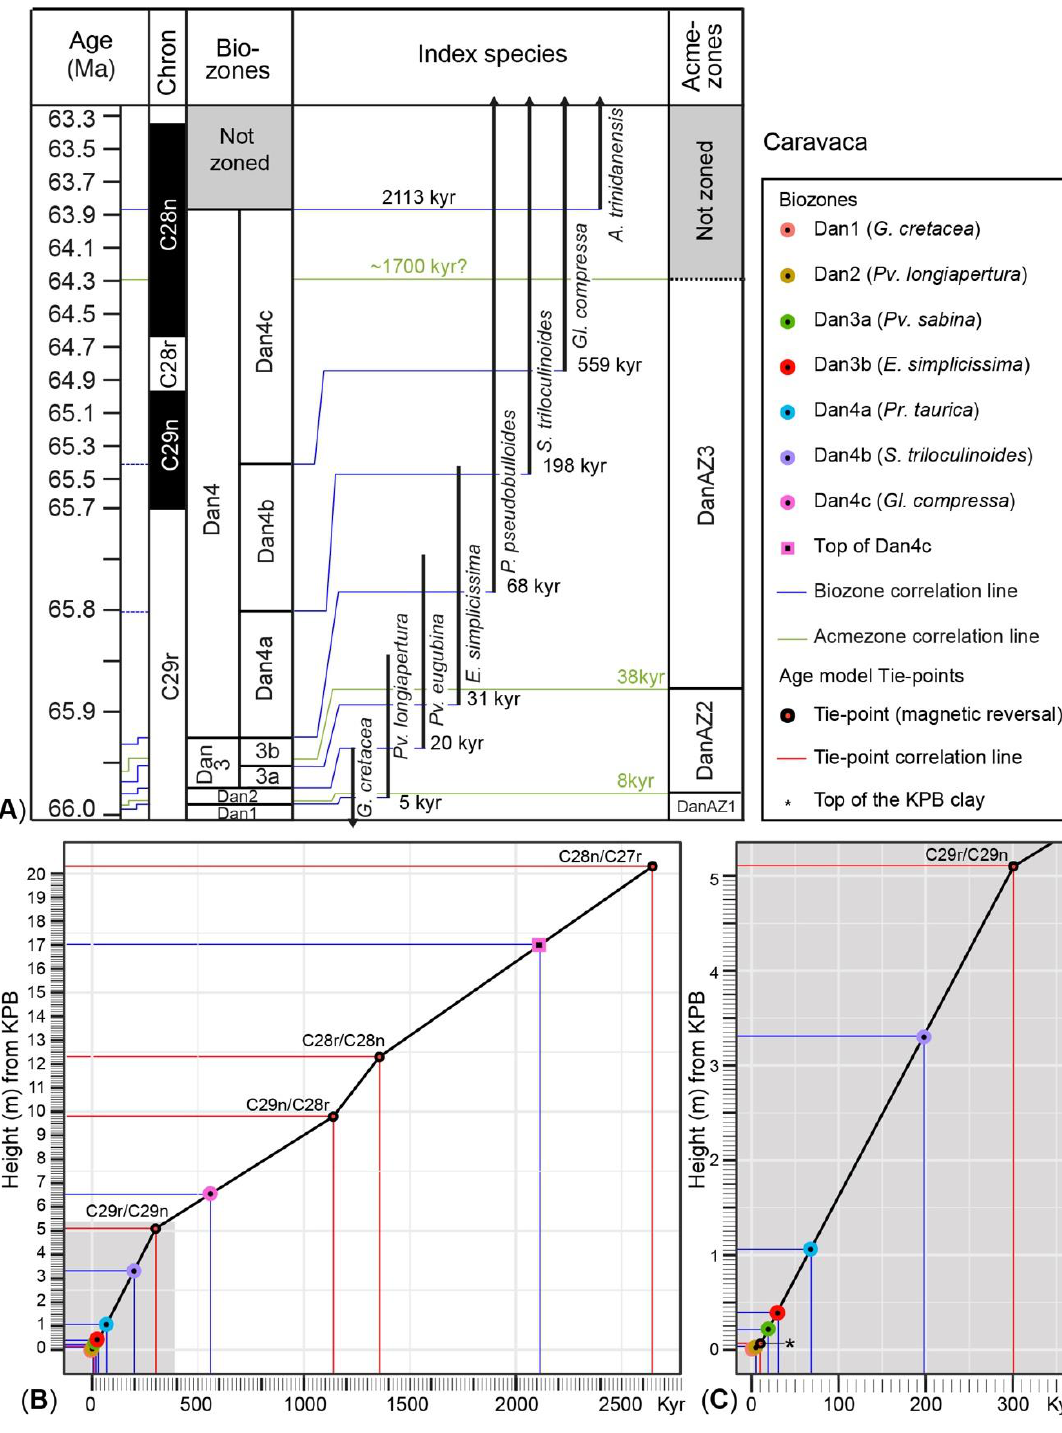
Figure 4. Magnetochronological calibration of the bases of the biozones and acme zones proposed in this report, based on GTS 2020 [54] and the bio-magnetostratigraphic correlation in the Caravaca reference section [8,35]; ( A ) — bio-magnetochronological correlation and magnetochronologically calibrated ages of key biohorizons; ( B , C ) — Graphic correlations to establish the age model at Caravaca, using as tie-points (key-horizons) the KPB, the top of the KPB dark clay bed, and the magnetic reversals.